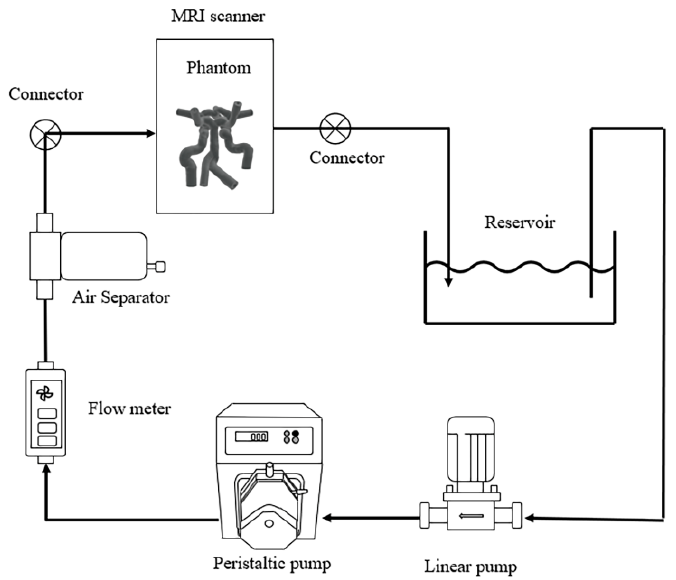
Figure 3. A schematic diagram for the experimental setup; the black arrows indicate the blood flow. Note that plastic connectors compatible with magnetic resonance imaging (MRI) are used to ensure proper extension of the tubes.